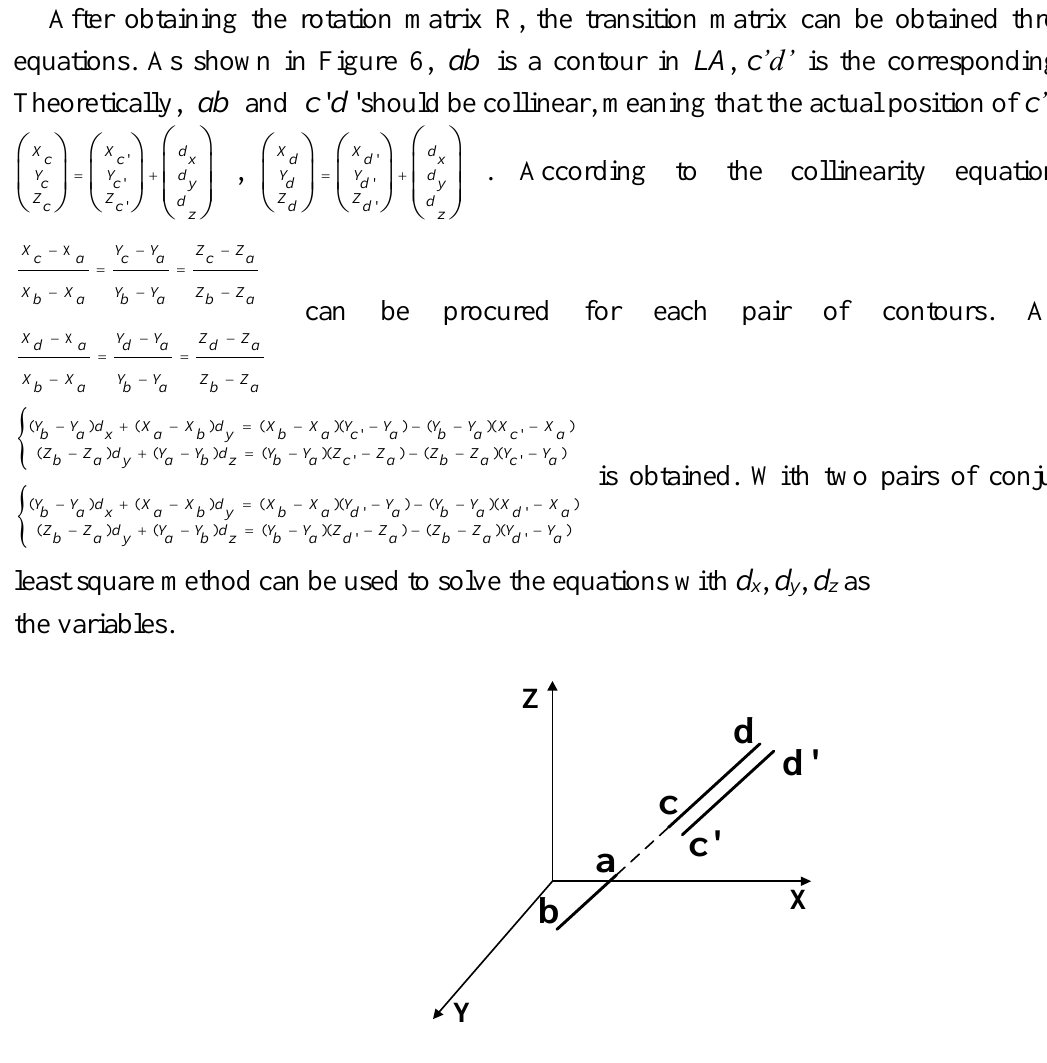
Figure 6. A sample of collinear